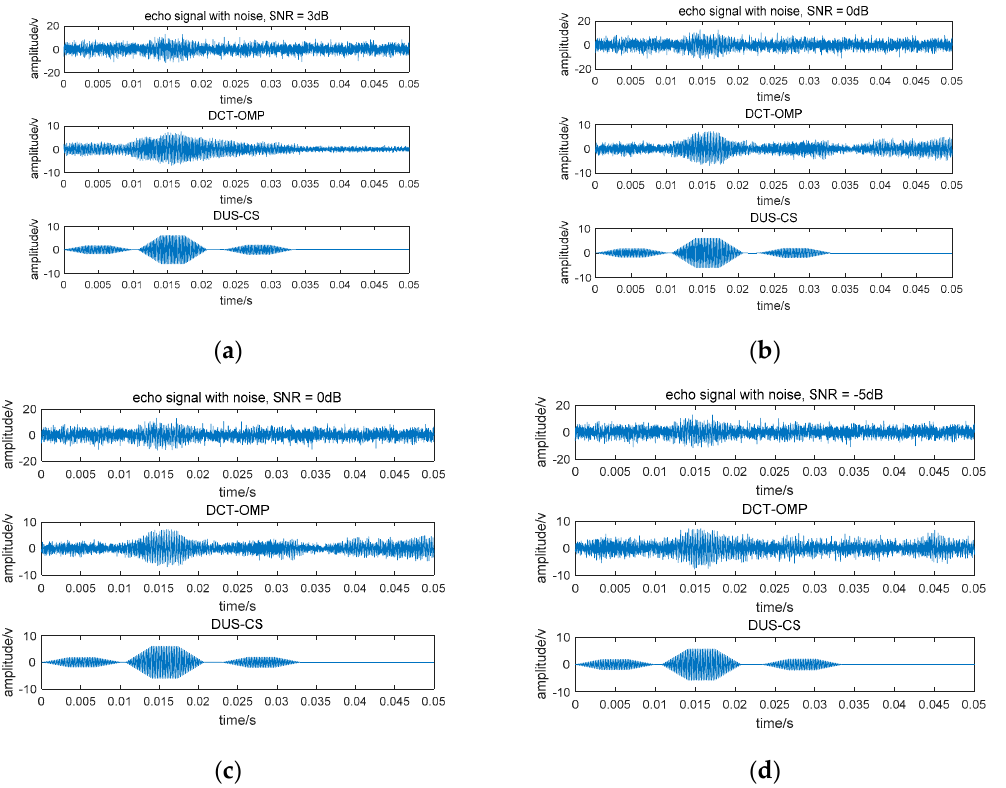
Figure 3. Reconstruction signal at a compression ratio of 100% (no compression). ( a ) SNR = 3 dB;